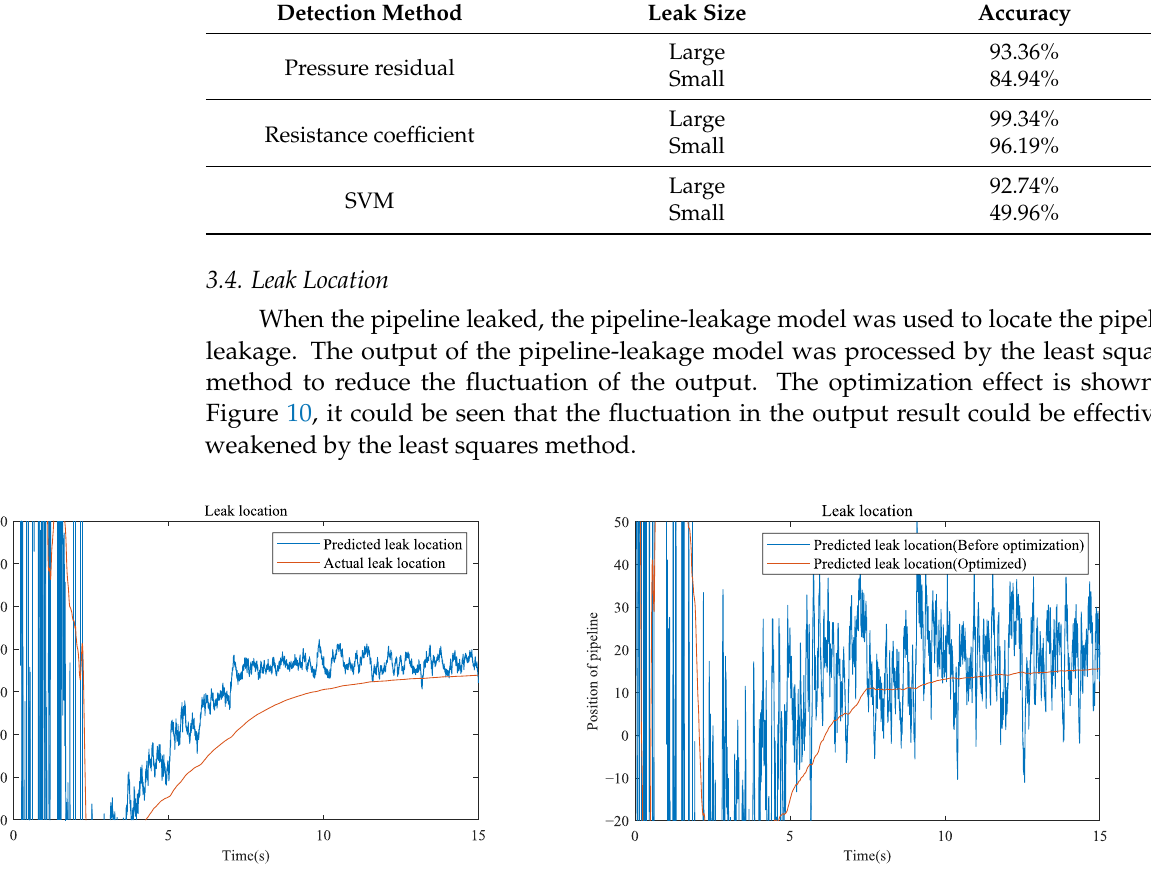
Figure 10. The least squares method reduced model output fluctuations. ( a ) Large leakage; ( b ) small leakage.